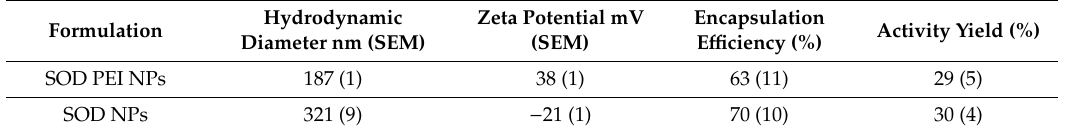
Figure 4. ( a ) Schematic representation of superoxide dismutase (SOD) PEI NP synthesis. ( b ) Schematic illustration of in vitro assay for SOD PEI NPs. ( c ) SOD activity in cell upon treatment with SOD PEI NPs, SOD NPs or SOD. 1 U = 1 nmol non-reduced NBT / min. ( d ) Comparison between SOD activity in cell upon treatment with SOD PEI NPs versus treatment with SOD NPs and SOD. Error bars represent the Standard Error of the Mean, n = 3. Table 2. Hydrodynamic diameter, Zeta potential and encapsulation e ffi ciency and activity yield respect to free SOD of SOD-loaded NPs. SEM = Standard Error of the Mean, n =